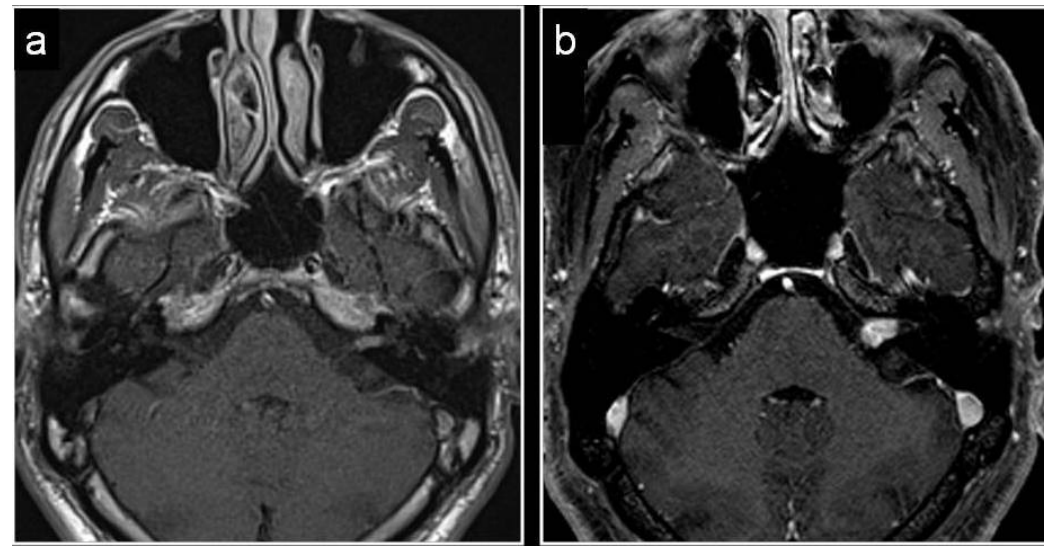
Fig. 1. Preoperative MR – progression of vestibular schwannoma on the left side: a) year 2014; b) year